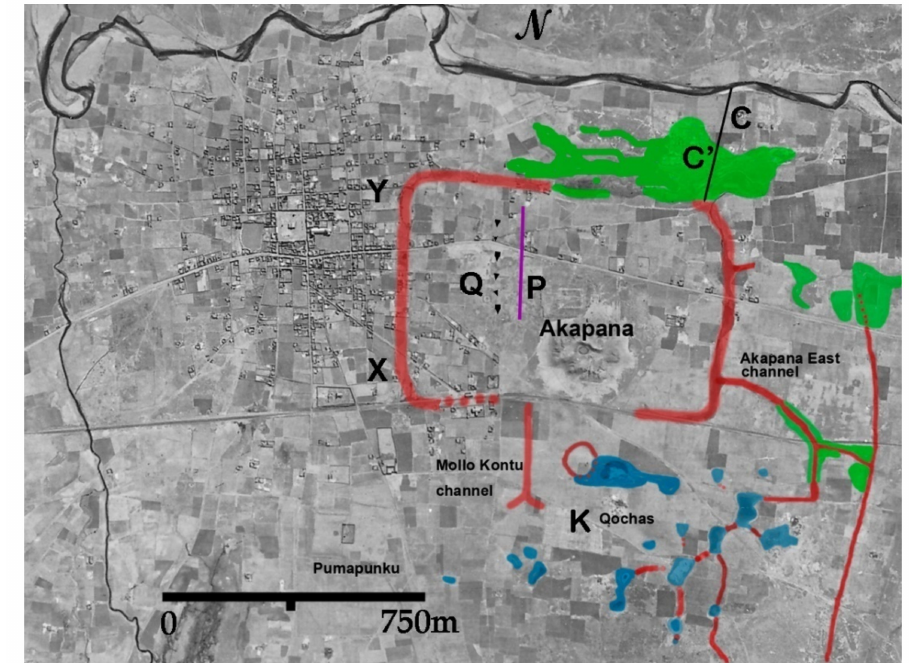
Figure 3. Details of the (red) intersection path of the Mollo Kontu M channel with the southern arm of the perimeter drainage channel. Note that excess perimeter drainage channel water is drained to the Tiwanaku River through channel C and the floodplain agricultural (green) area C’. The Akapana East Channel shown supplies water to qocha agricultural and (green) pasturage areas to the southwest and served to drain excessive water to the perimeter drainage channel to maintain required moisture levels for agriculture and pasturage.